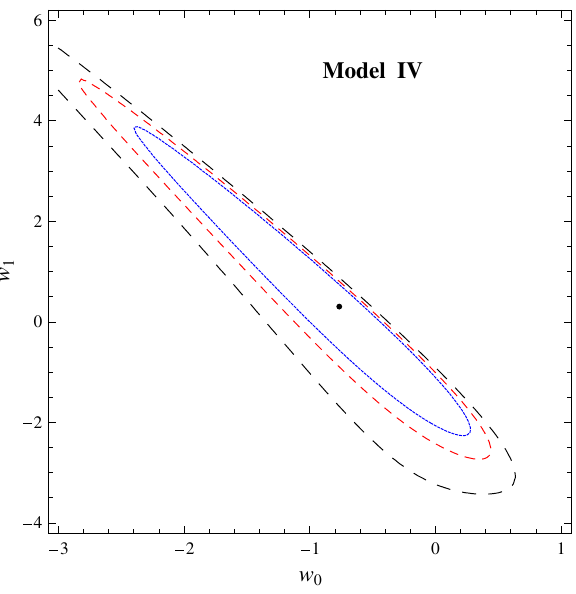
Fig. 25 Variations of w 0 and w 1 in the joint analysis (SNIa+BAO+CMB+Hubble) for the Efstathiou parameteriza- tion (Model IV). We plot the graphs for different confidence levels 66% (solid, blue), 90% (dashed, red) and 99% (dashed, black) contours for ( w 0 , w 1 ) by fixing the other parameters β = − 0 . 5 , D = 5 ,w = − 0 . 3 ,ω = 0 . 2 ,v = 0 . 5 , f = 2 , n = m 0 0 3 , H 0 = 72 ,(cid:13) m 0 = 0 . 3 ,(cid:13) k 0 = 0 .